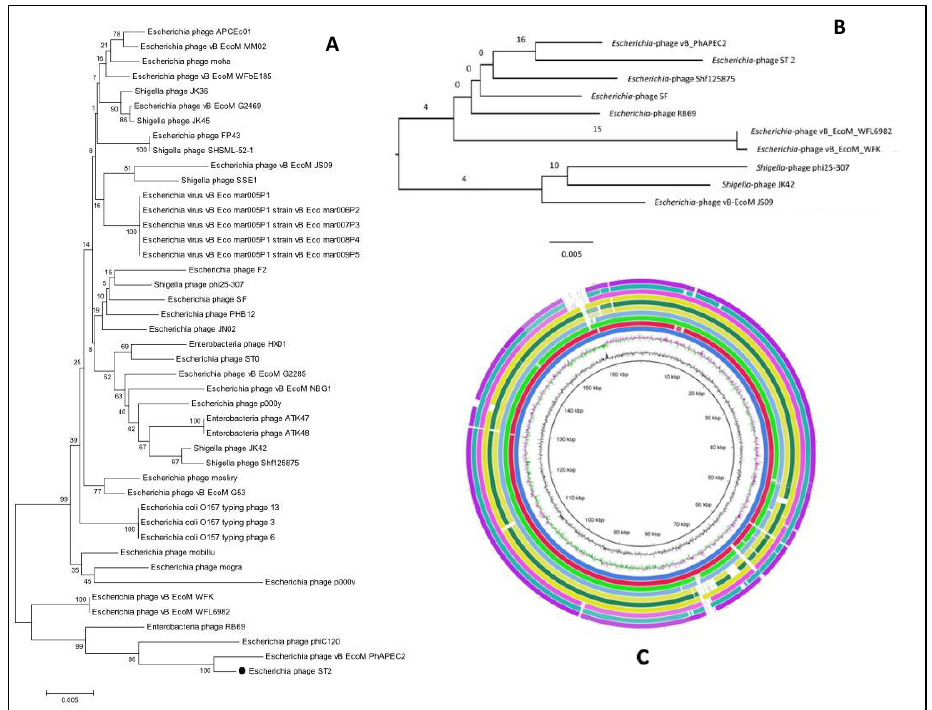
Figure 10. ( A ) phylogenetic tree of Escherichia phage ST2 based on the sequence of terL gene, ( B ) shows the phylogenetic GBDP tree and ( C ) genome comparisons with the closest phages obtained from the NCBI GenBank using BRIG software version 0.95 .